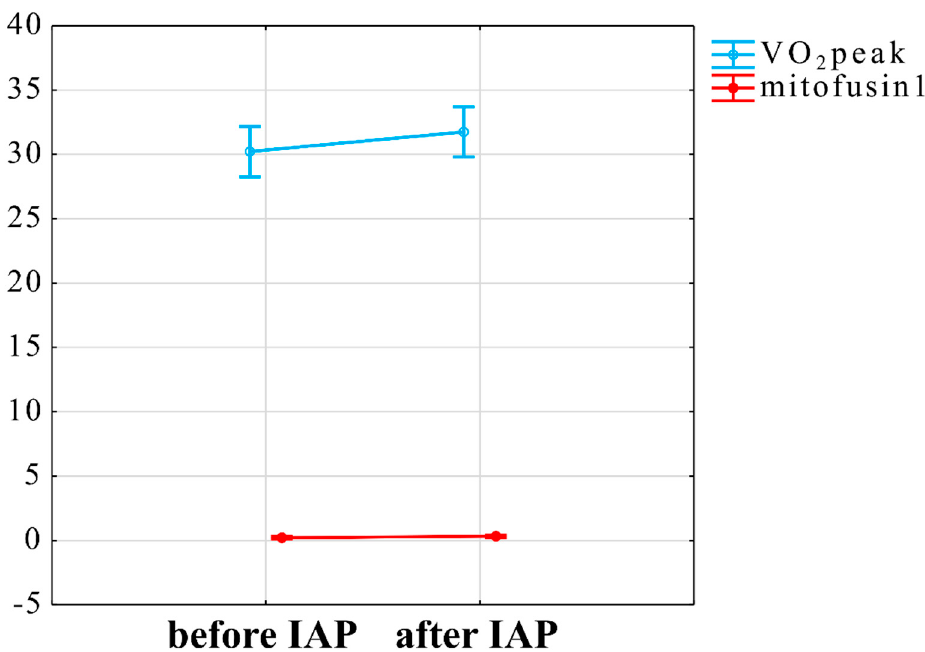
Figure 5. Interaction between influence of IAP on VO 2 peak and Mfn1. VO 2 peak—maximal oxygen consumption obtained during physical exercise, mitofusin1—level of mitofusin1, IAP—Individualised Activity Program.